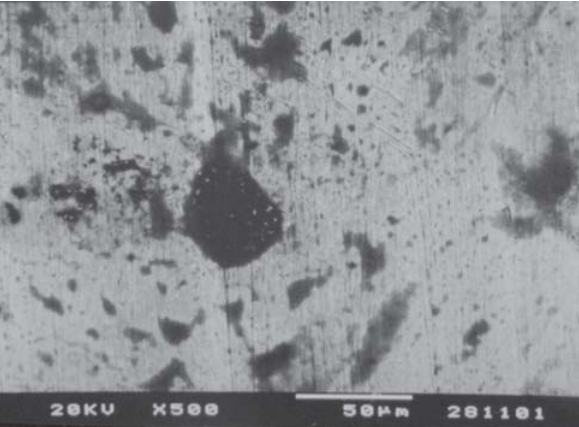
FIGURE 2- Implant submitted to the action of fluoride ions F(+). Corrosion by pitting 500x